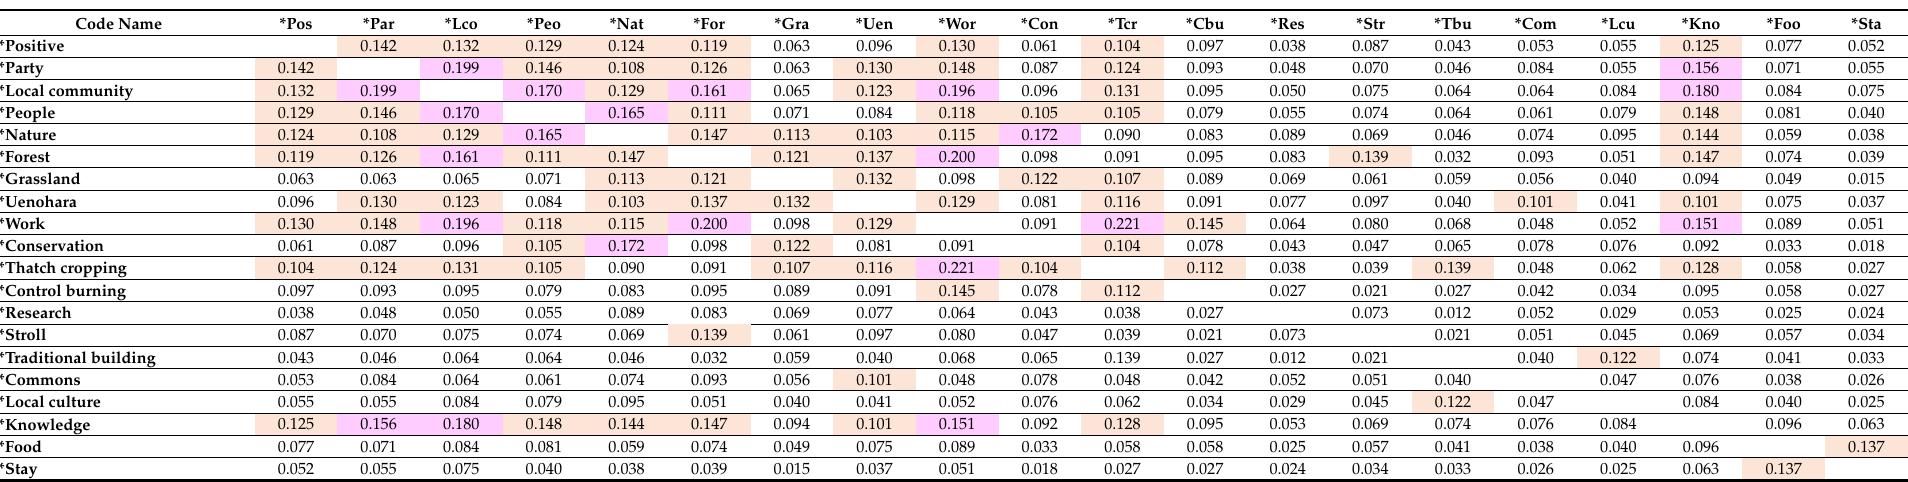
Table 5. Similarity matrix between each